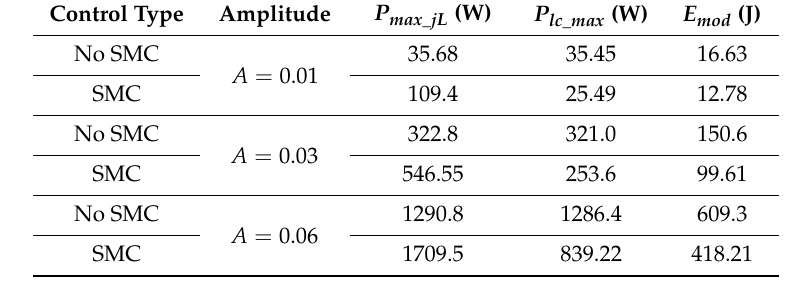
Table 1. Comparison of power consumption indicators for the system with SMC and with No SMC.